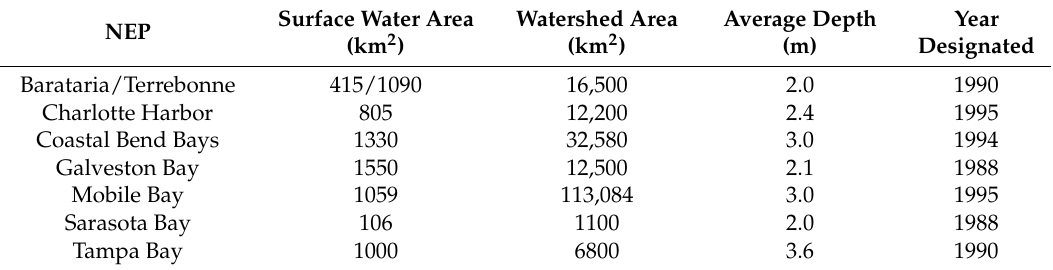
Table 1. National Estuary Programs (NEP) studied here and relevant